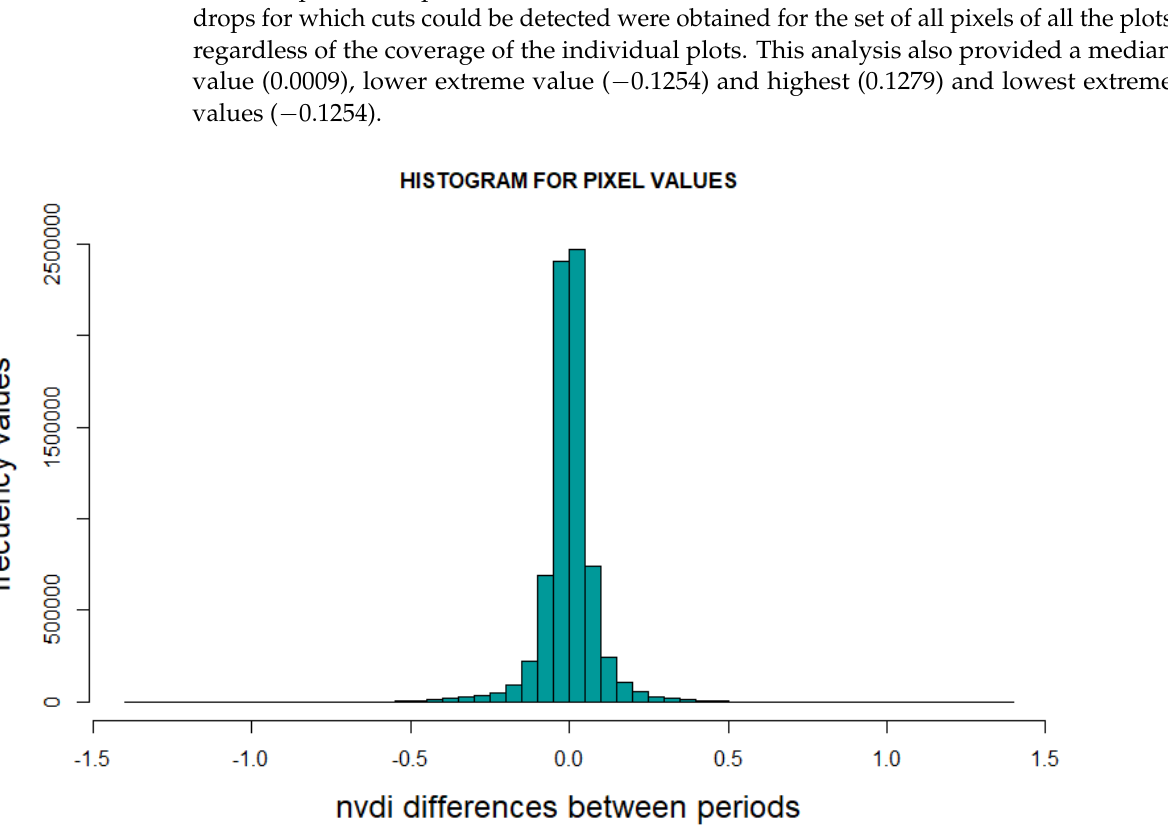
matching-learning algorithm that will show us a series of sequential decisions [55]. This